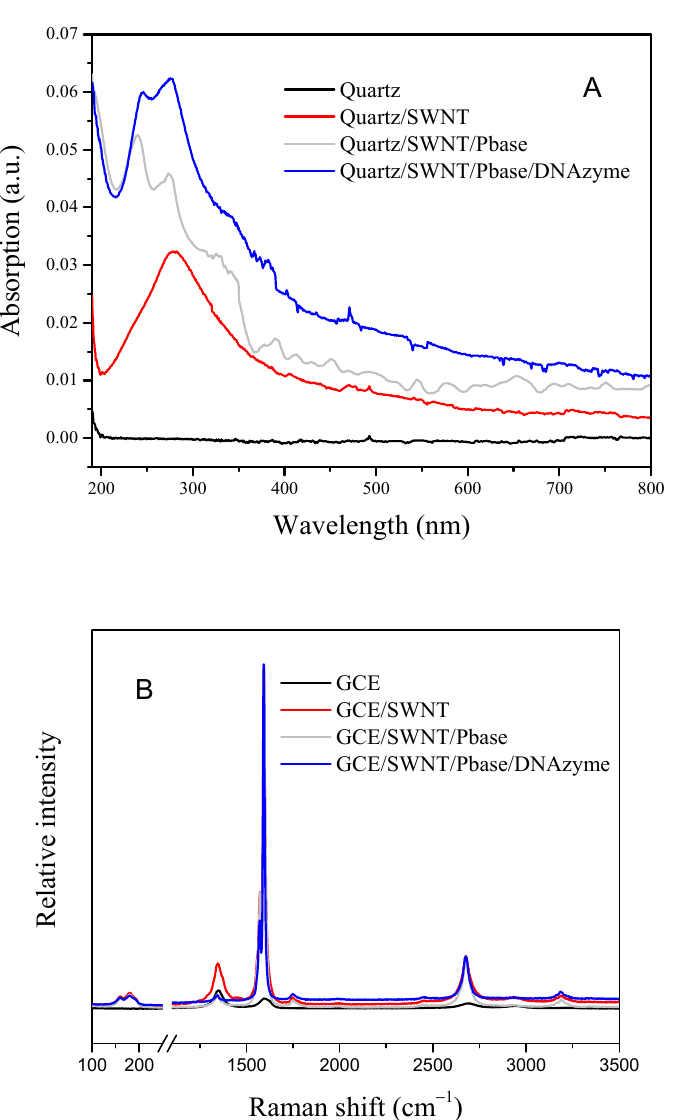
Figure 2. ( A ) UV-visible spectrum of blank quartz modified with SWNT, PBASE, and DNAzyme; ( B ) Raman spectrum of GCE modified with SWNT, PBASE, and ( B ) Raman spectrum of GCE modified with SWNT, PBASE, and DNAzyme.